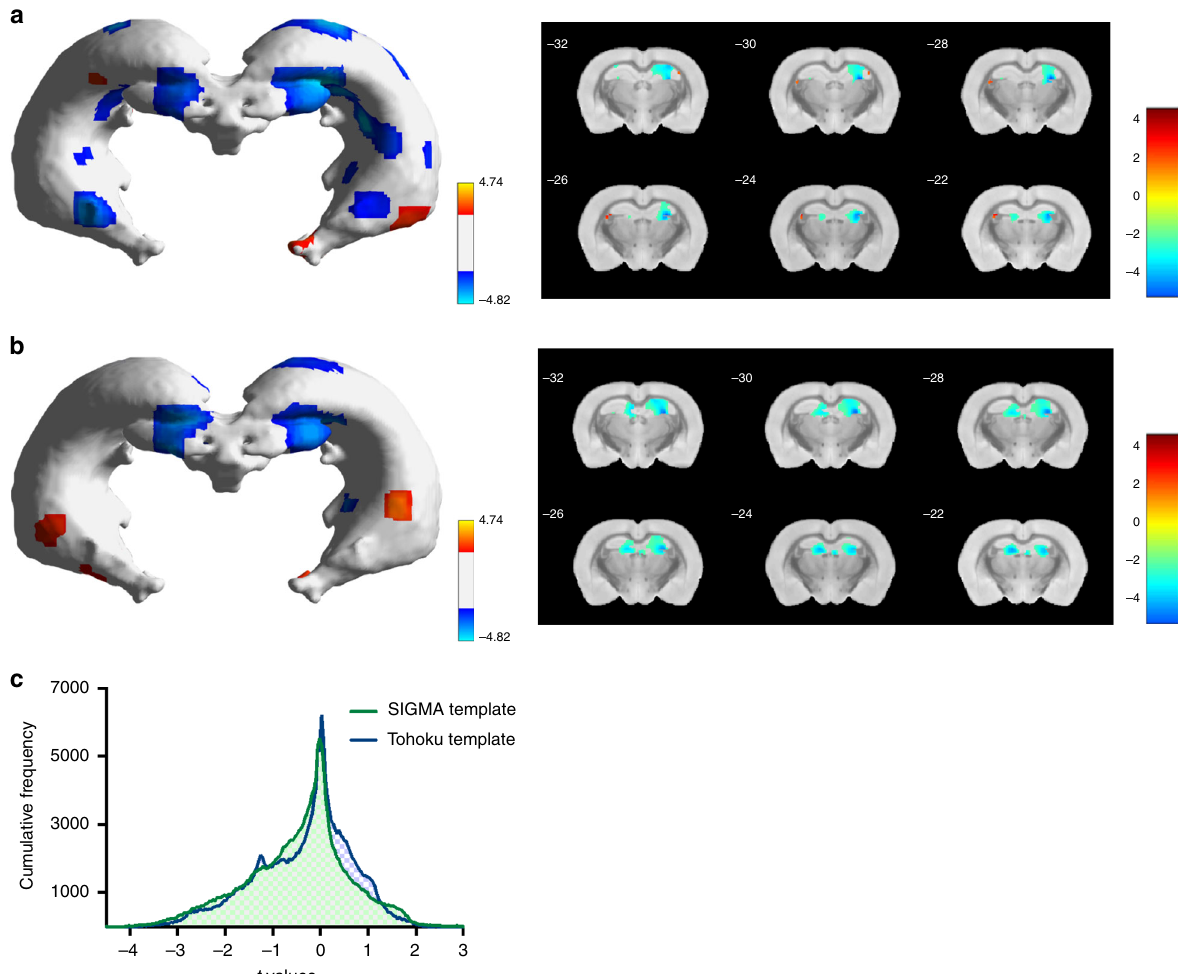
Fig. 3 Comparison of VBM analyses performed using the SIGMA or Tohoku resources. a Hippocampus mesh plot representing the surface map of Gray Matter Concentration changes between control and stress animals at the same threshold obtained from VBM analysis using the SIGMA priors and template. b Hippocampus mesh plot representing the surface map of Gray Matter Concentration changes between control and stress animals at the same threshold obtained from VBM analysis using the Tohoku priors and template. c Comparison of t -values distribution within the hippocampus when performing the VBM analysis with the SIGMA or the Tohoku template. Control and Stress animals ( n = 6 for each) were compared using the two sample Student t -test implemented in SPM8 ( t = 1.812, df = 10, p < 0.05, 50 voxels). Source data are provided as a Source Data fi